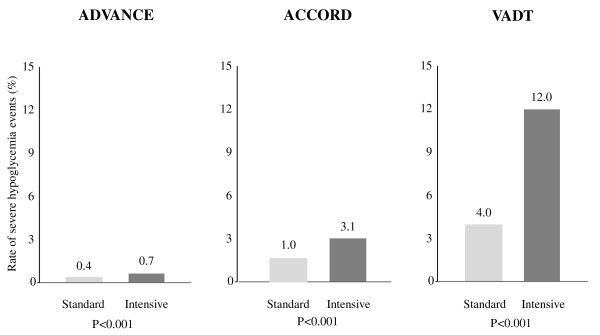
Intensified treatment has been associated with an increase in the rate of hypoglycemia [4-6].